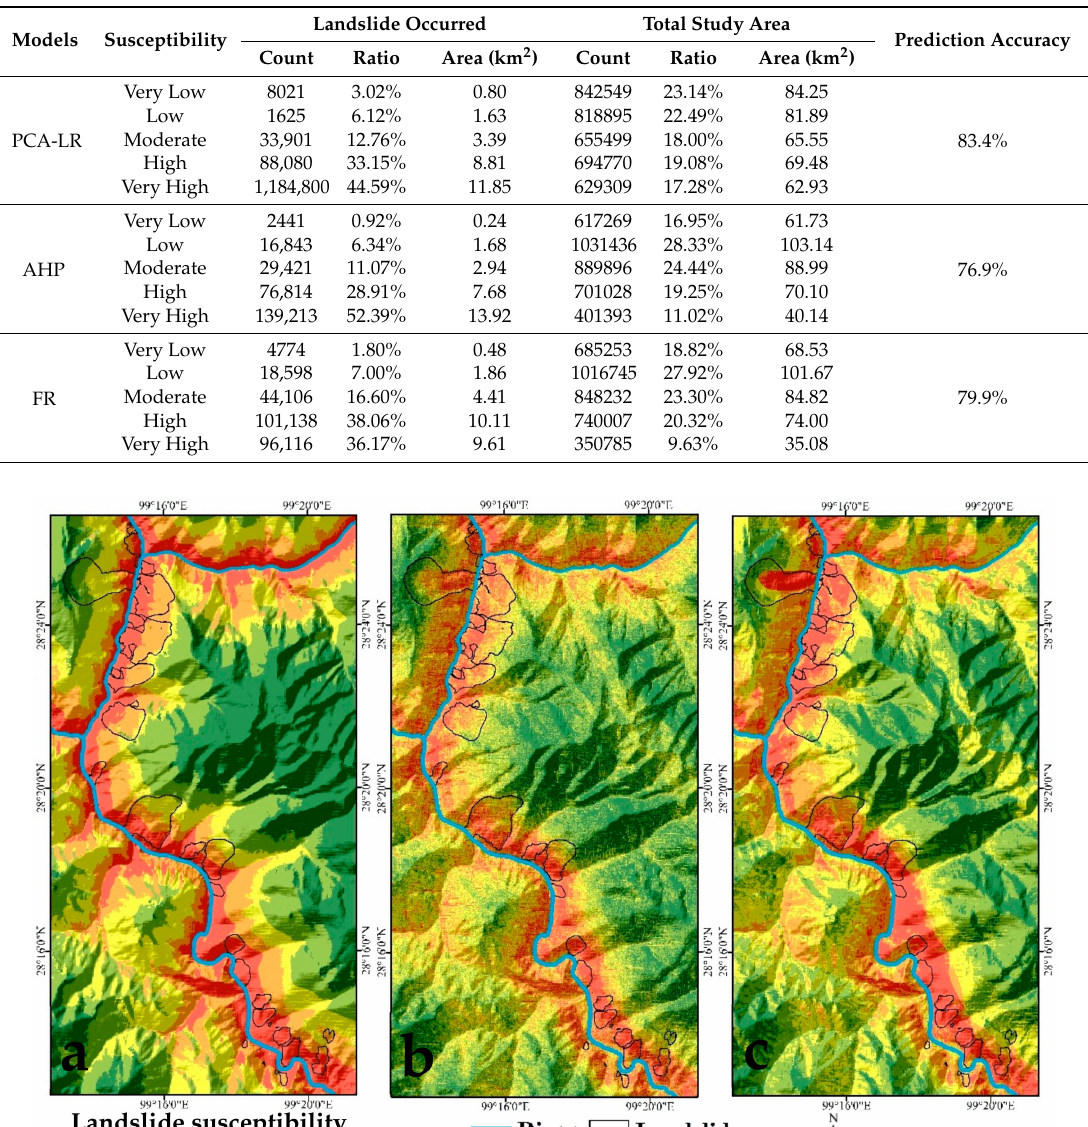
Table 10. Statistical results of the landslide susceptibility mapping. PCA-LR—principal component analysis logistic regression; FR—frequency ratio; AHP—analytic hierarchy process.